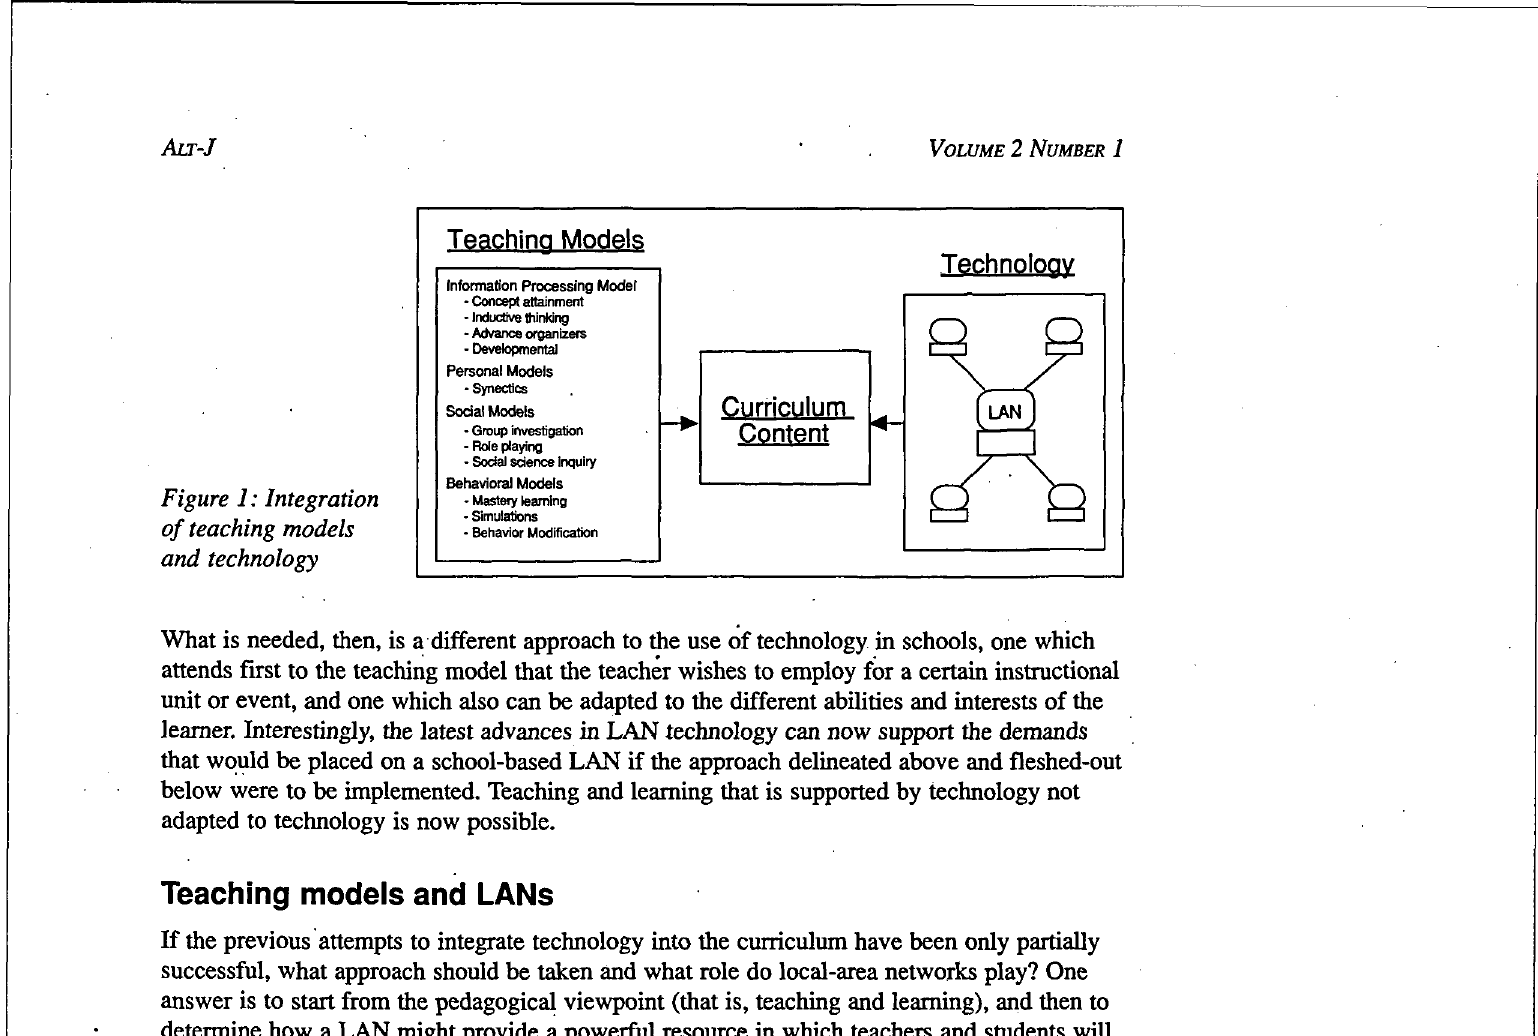
Figure 1: Integration of teaching